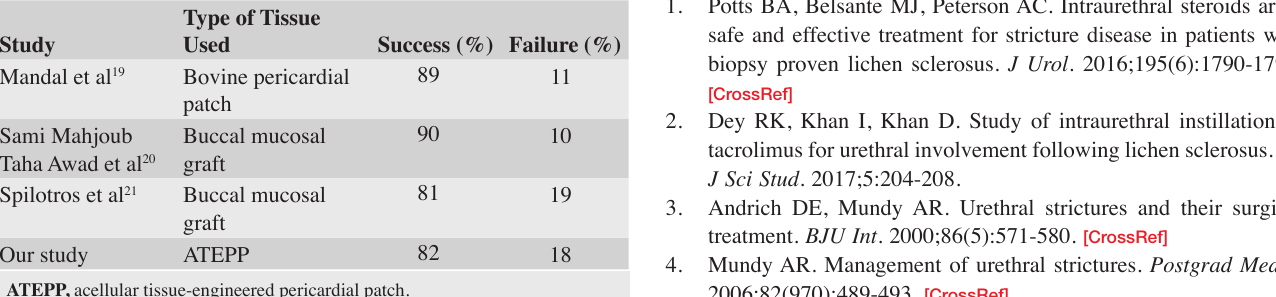
Table 4. Comparison of Success and Failure Rate Between ATEPP and Other Studies